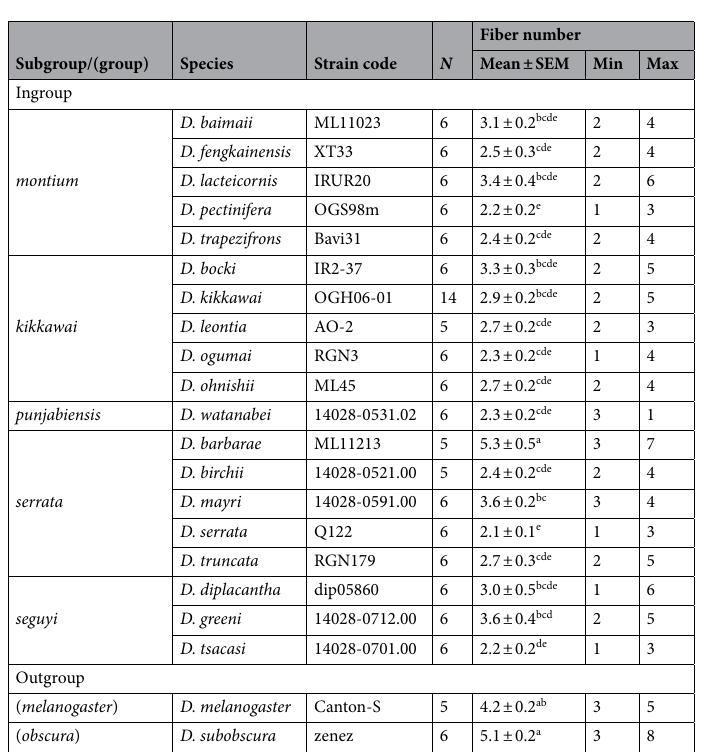
Table 2. The number of fibers composing an MOL in A5 of male flies of the Drosophila montium group species and outgroup species. N : The total number of male flies used in this analysis. The number of fibers (mean ± SEM) and the maximal and minimal number of fibers observed are given in 3 columns on the right- hand side. Statistical differences were evaluated by Kruskal–Wallis test (SPSS 22.0 for Windows) followed by the Tukey’s HSD test, and the results are shown with letters a–e written in superscript following the mean ± SEM values: the same letters indicate that no significant difference was found among the relevant values at P ≥